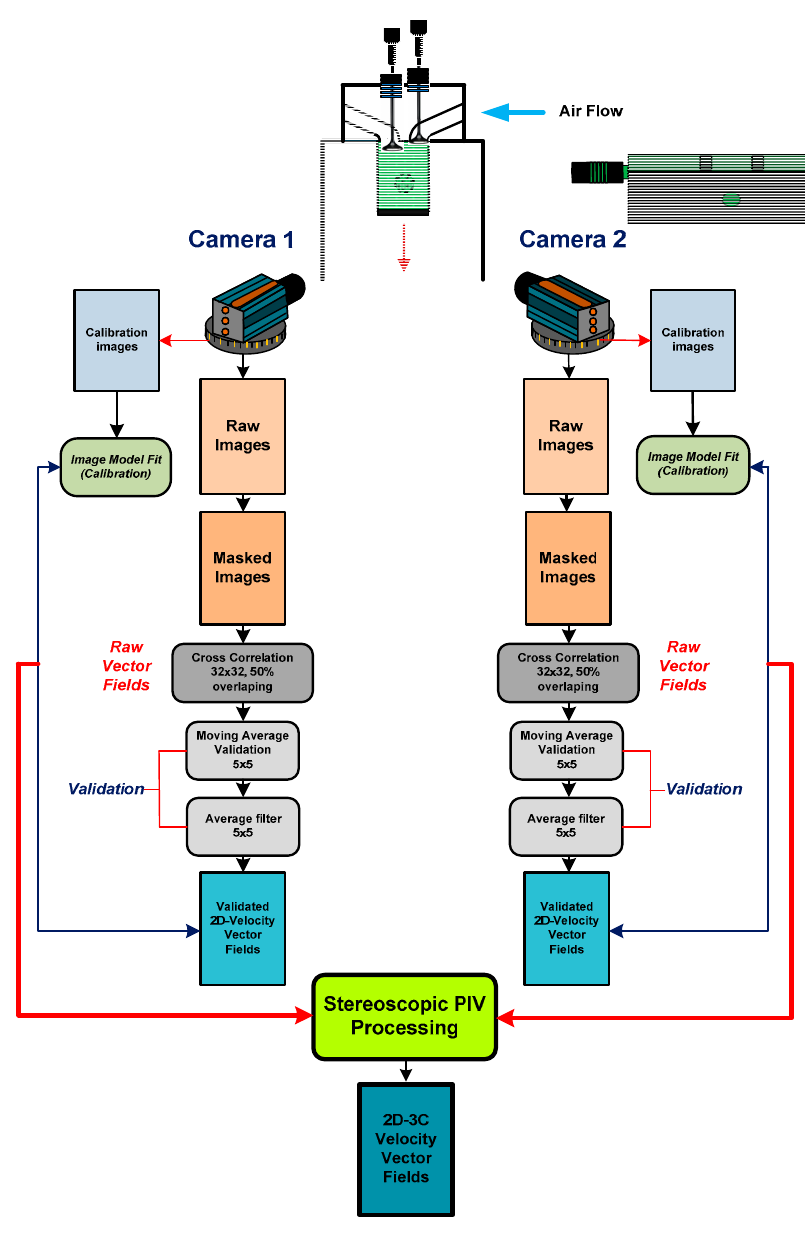
Figure 3. Flow chart representing vectors calculation process for stereoscopic PIV.